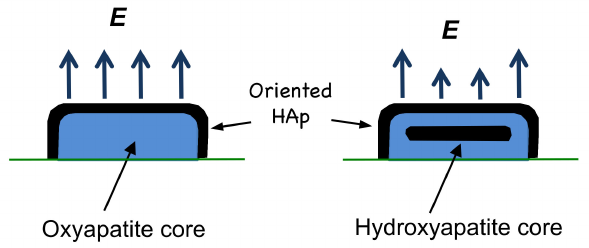
Figure 9. The hydroxyapatite and oxyapatite regions within a splat, where an oxyapatite core occurs for smaller splats and a hydroxyapatite core is found in larger splats. Both splats are normalized for ease of comparison. An 80- µ m-sized droplet, depicted to the right with a HAp core, would be 4.3-times larger in diameter and a 3-times higher, if extrapolated from the data shown in Figure